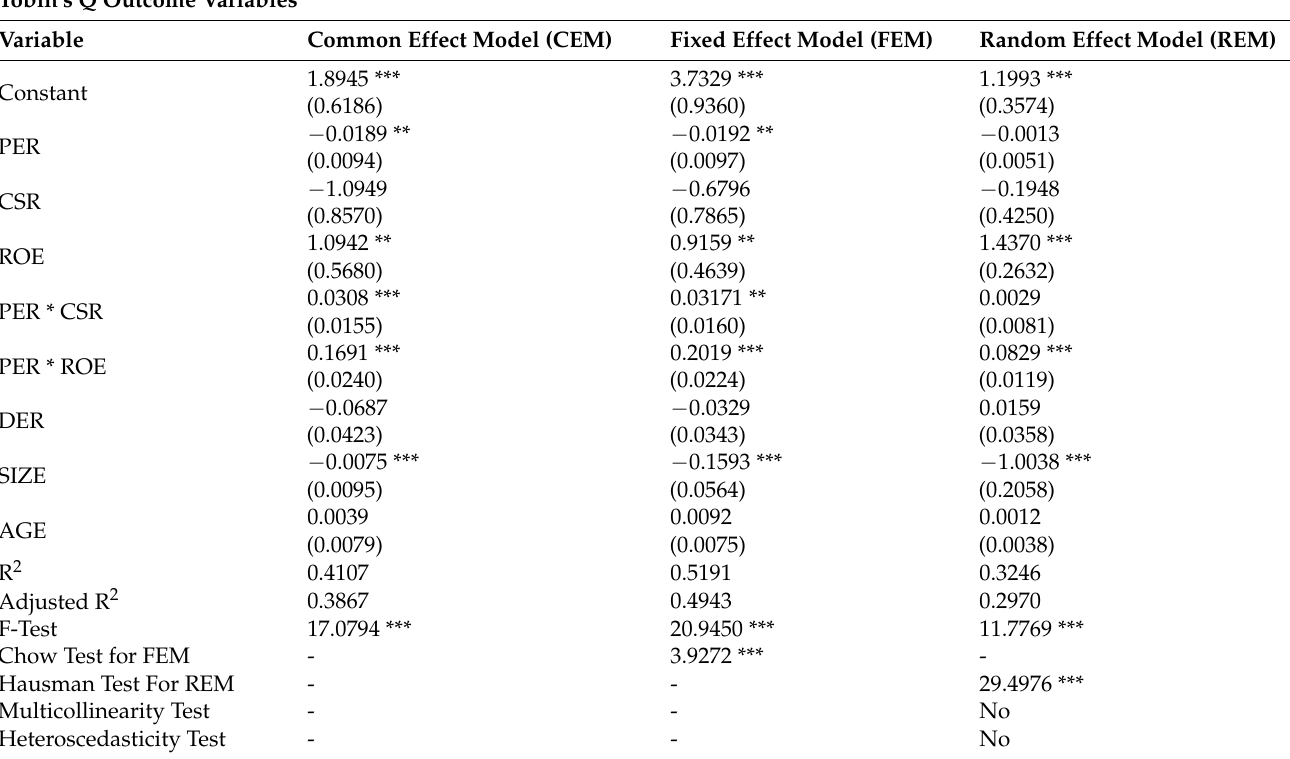
Table 4. Data panel results.